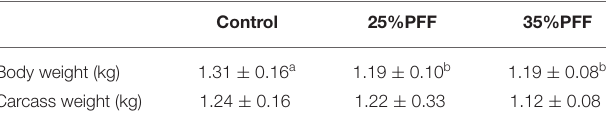
TABLE 1 | Effect of probiotic fermented feed on body weight and carcass weight in ducks. Control